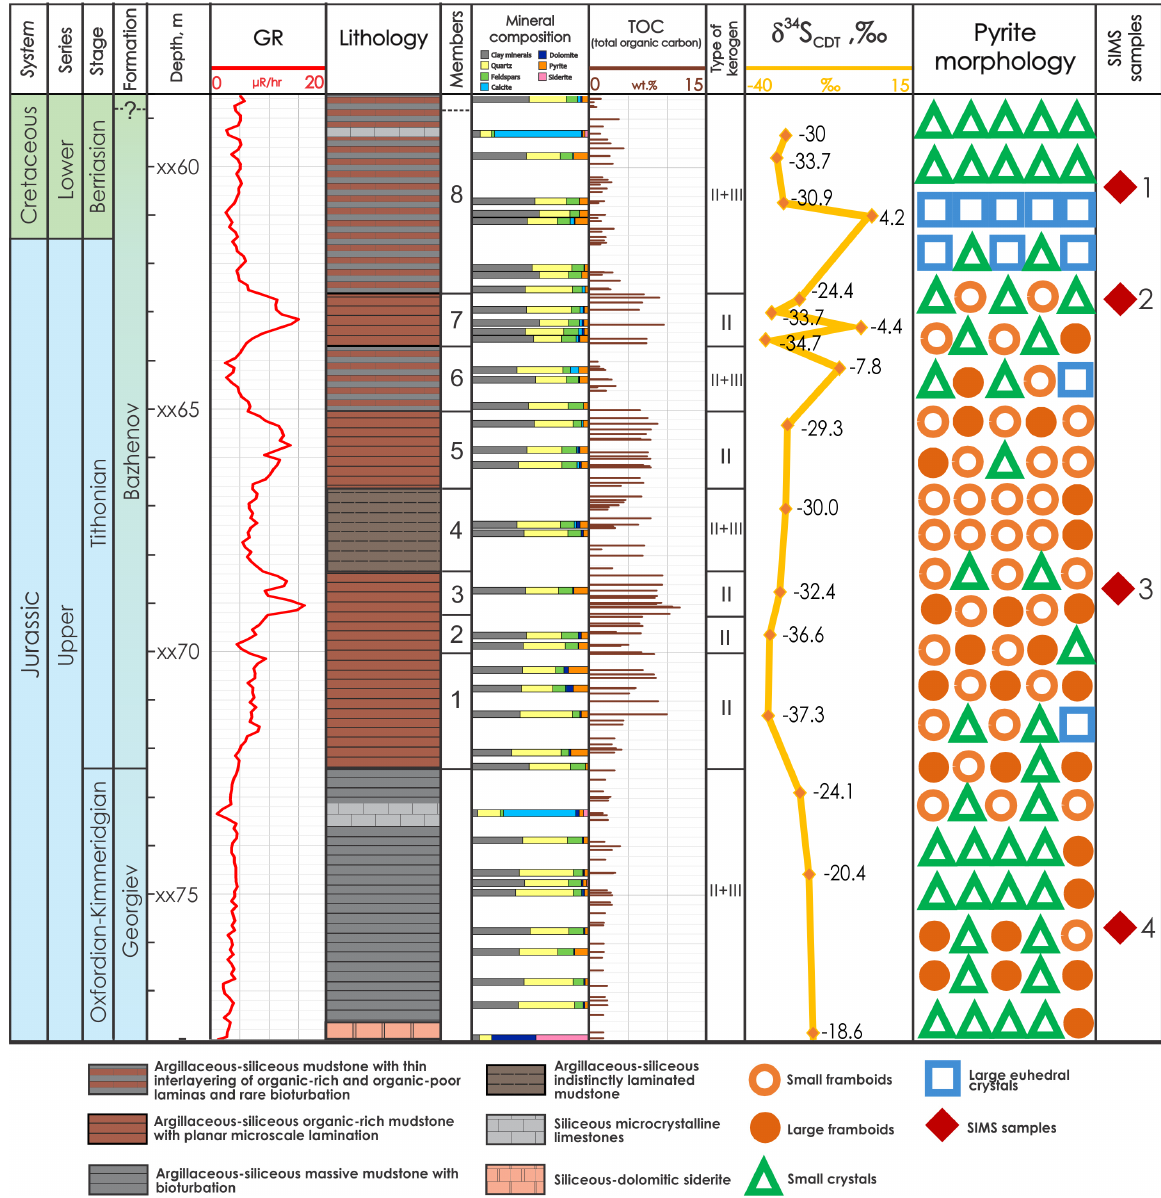
Figure 2. Well section: stratigraphy, gamma ray log, stratigraphic column, mineral composition of the rocks, amount of organic matter, types of kerogen and distribution of δ 34 S. Pyrite morphology column shows relative proportion of different morphotypes in the rocks investigated with SEM. Diamonds on the right column correspond to the samples selected for SIMS isotope analyses.